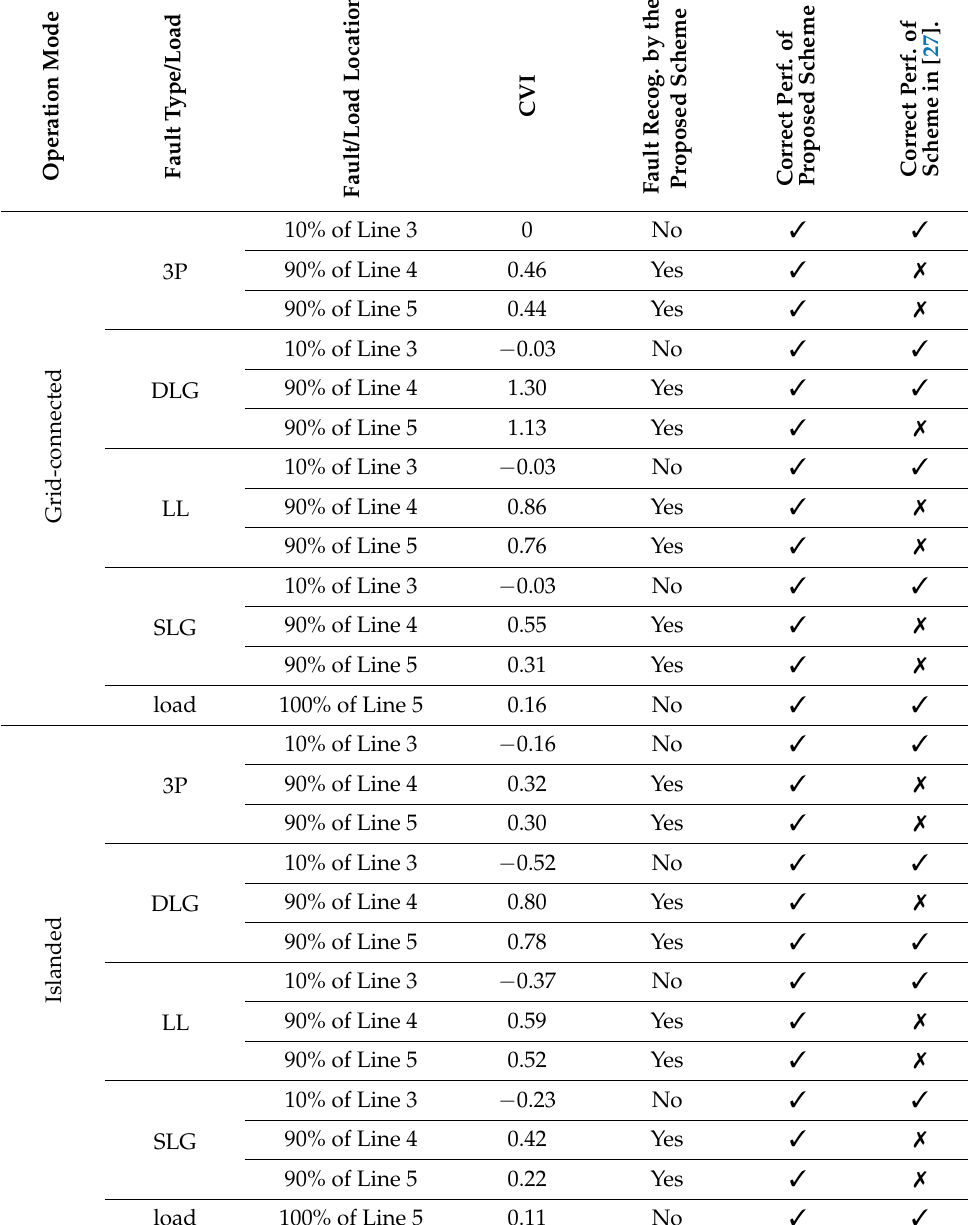
Table 7. Backup protection performance in pre-fault conditions